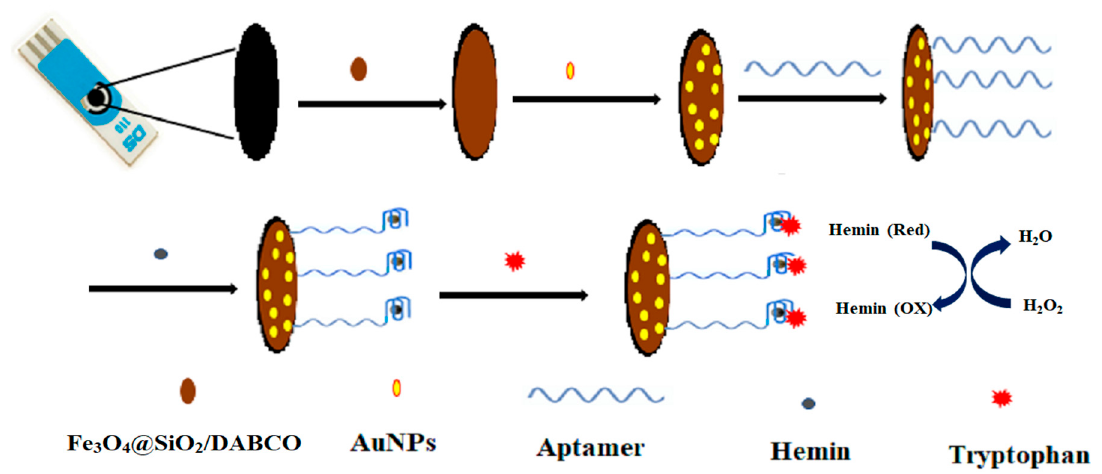
Figure 1. Schematic illustration for the construction of electrochemical Trp aptasensor.